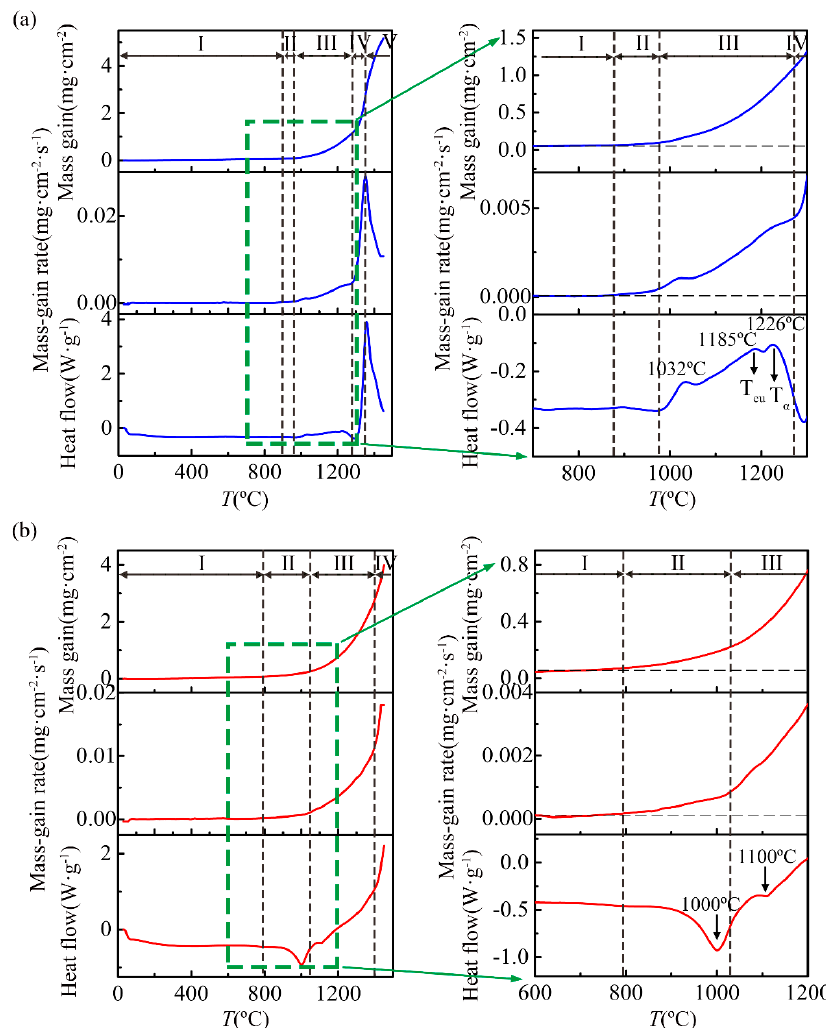
Figure 3. Stage divisions of the non-isothermal oxidation process for the ( a ) Ti-46Al-2Cr-5Nb and ( b ) Ti-24Al-15Nb-1.5Mo alloys according to the evolution of the mass-gain rates.